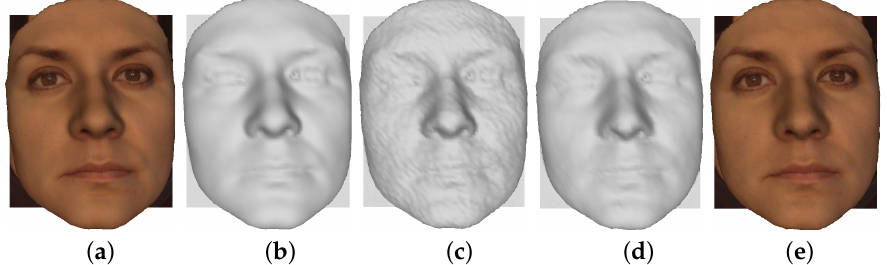
Figure 18. The results obtained by our filter on different models. Column ( a ) illustrates the model with texture, column ( b ) shows the ground truth of the mesh obtained by a 3D scanner, ( c ) is the same mesh after noise, ( d ) shows the models filtered by our method without texture and ( e ) shows the textured filtered